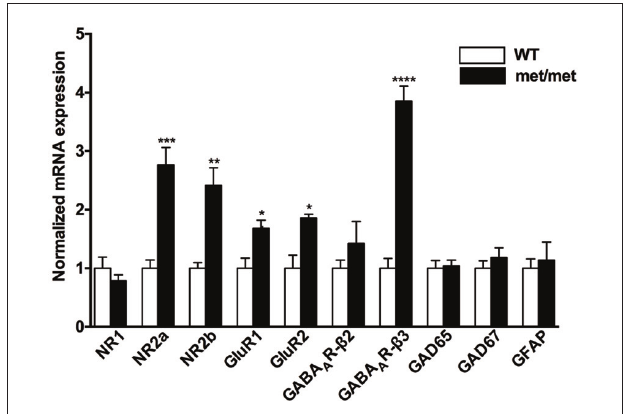
FIGURE 2 | Altered mRNA expression of glutamatergic and GABAergic receptor subunits. NR2a and NR2b subunits for NMDA receptors, GluR1 and GluR2 subunits for AMPA receptors, as well as GABA A receptor β 3 subunit were up-regulated in BDNF Met / Met mice (WT: N = 11; BDNF Met / Met : N =